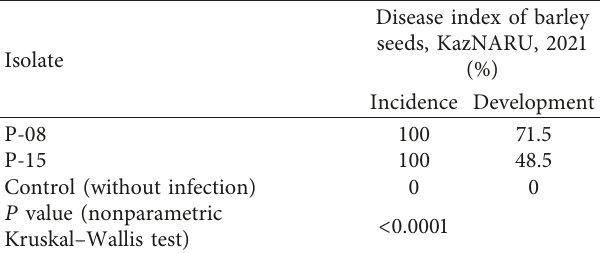
Table 2: The spread and development of symptoms in barley seeds in the pathogenicity test of two isolates of B. sorokiniana (PDA, at 23–25 ° C, KazNARU,